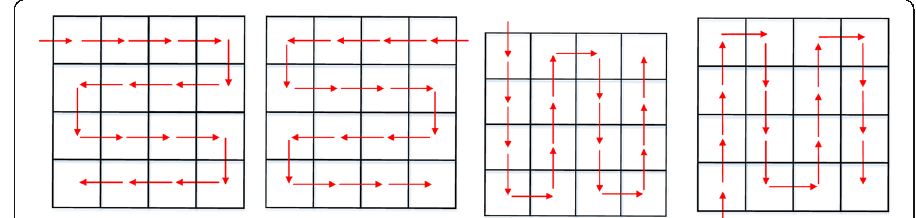
Fig. 1 Four scanning modes for co-frequency